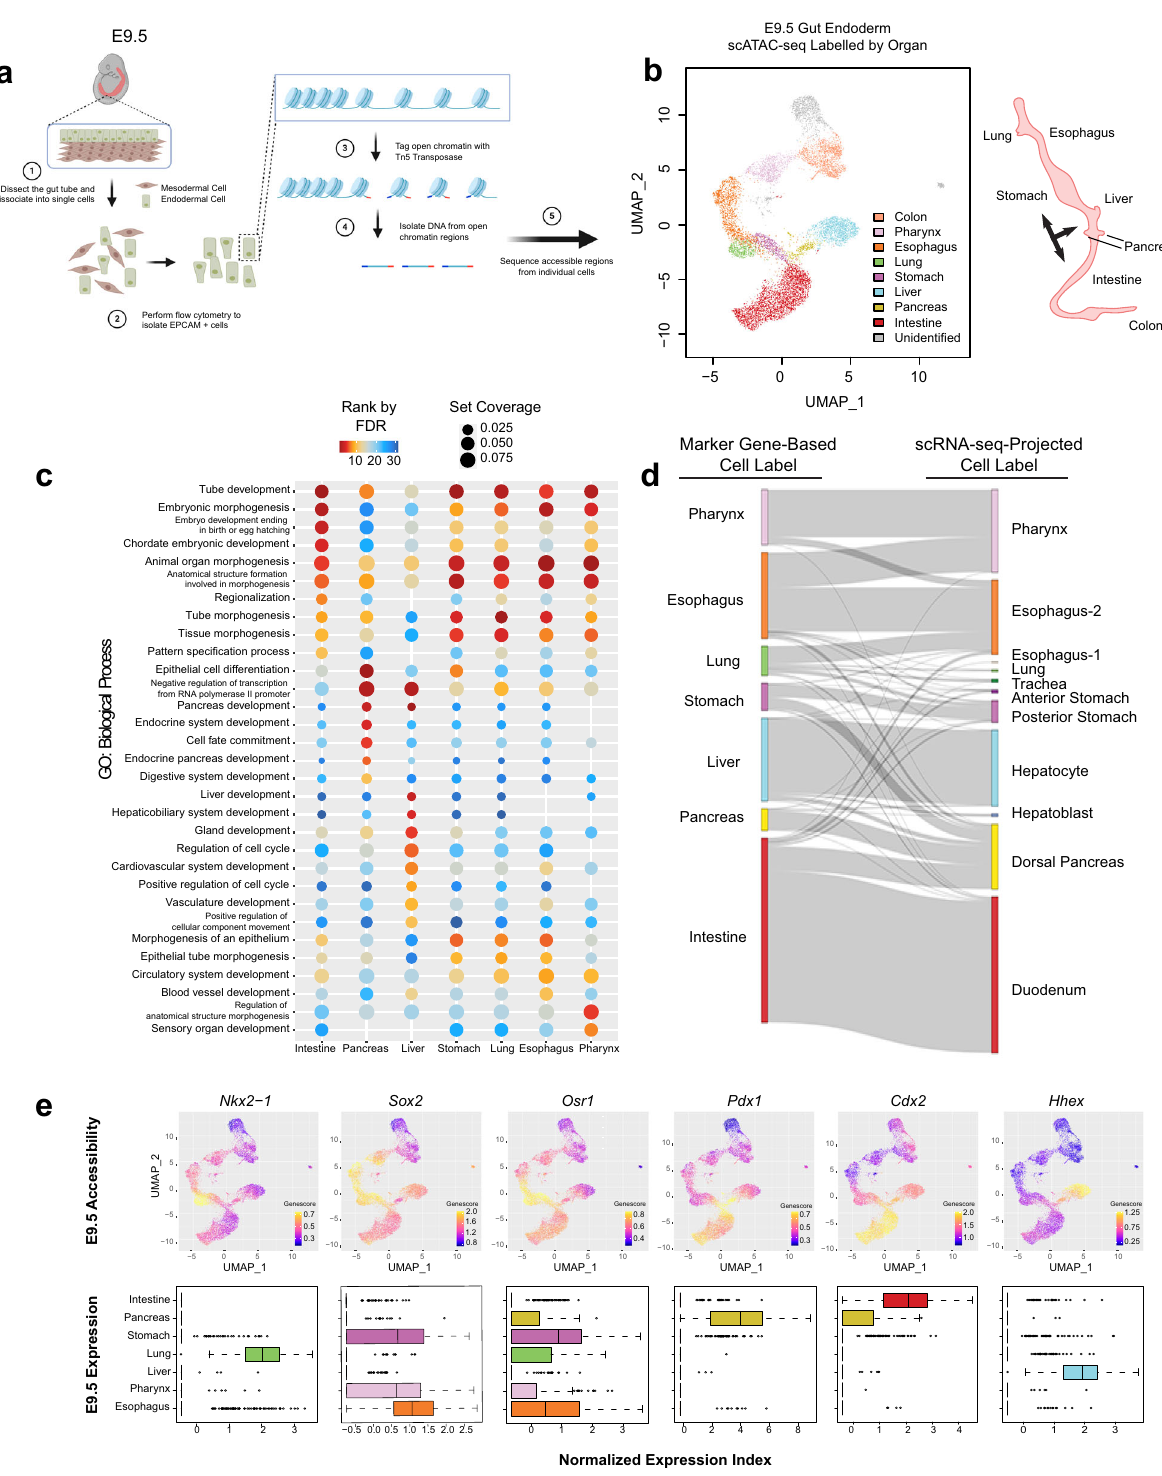
accessibility patterns associate with lineage-speci fi c TF binding events, which program lineage fate decisions into individual cells of the early gut tube. Ultimately, lineage fate decisions require transcriptional activation. By integrating our scATAC-seq data with scRNA- seq data from published E9.5 fore- and mid-gut endodermal cells 10 , we examined the relationship between patterns of NATURE COMMUNICATIONS| (2022) 13:2965